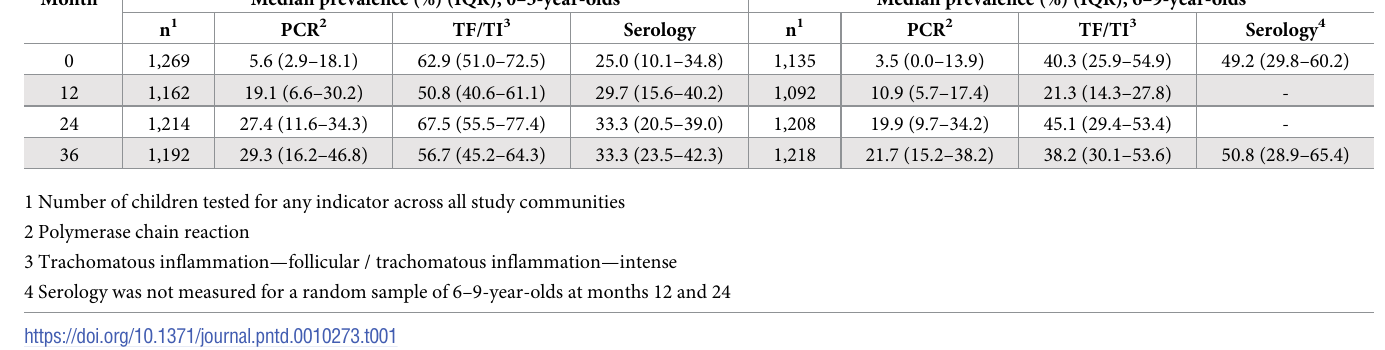
Table 1. Community-level prevalence of trachoma across 40 study communities by indicator, age group and month of follow-up visit. Month Median prevalence (%) (IQR),